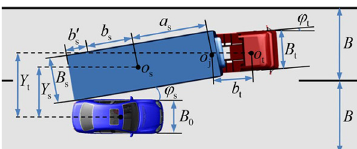
Figure 4 Critical position of safe